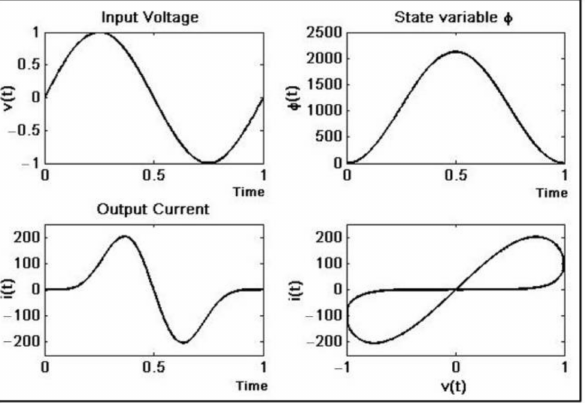
Figure 3. Memristor time response simulation. v ( t ) = 1sin(2 π ft ), f = 60 Hz, h = 0.05, α = 0.677 × 10 − 3 , β = 0.029 × 10 − 3